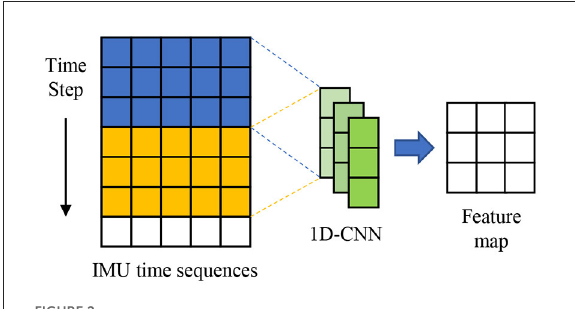
FIGURE2 Illustration of the 1D convolution operation.